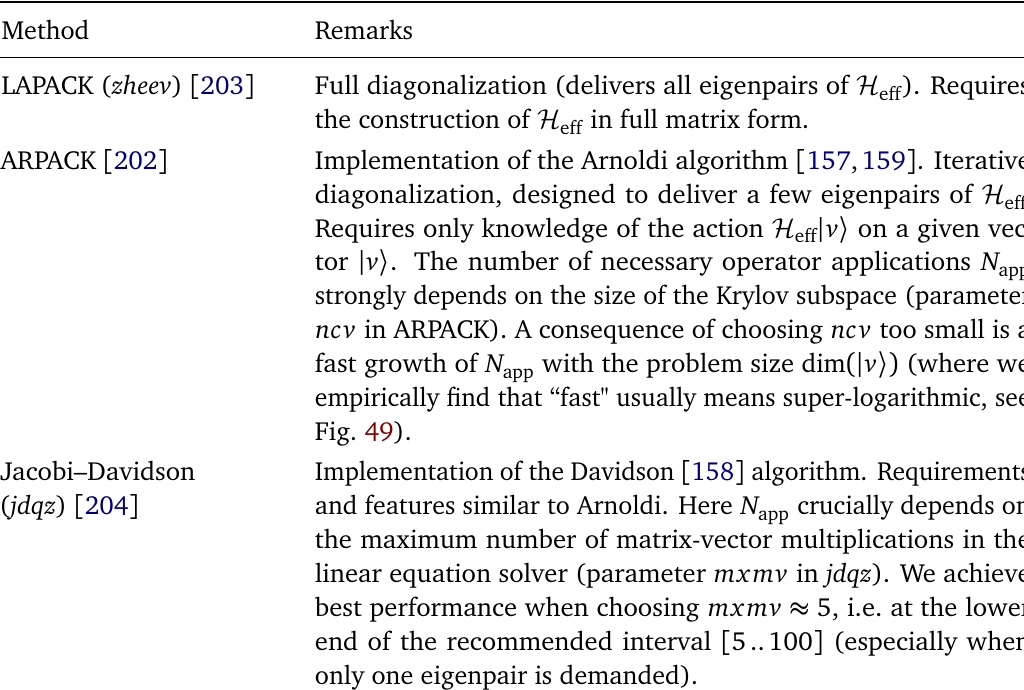
Table 1: List and characteristics of some numerical packages capable of finding eigenstates of a hermitian operator H